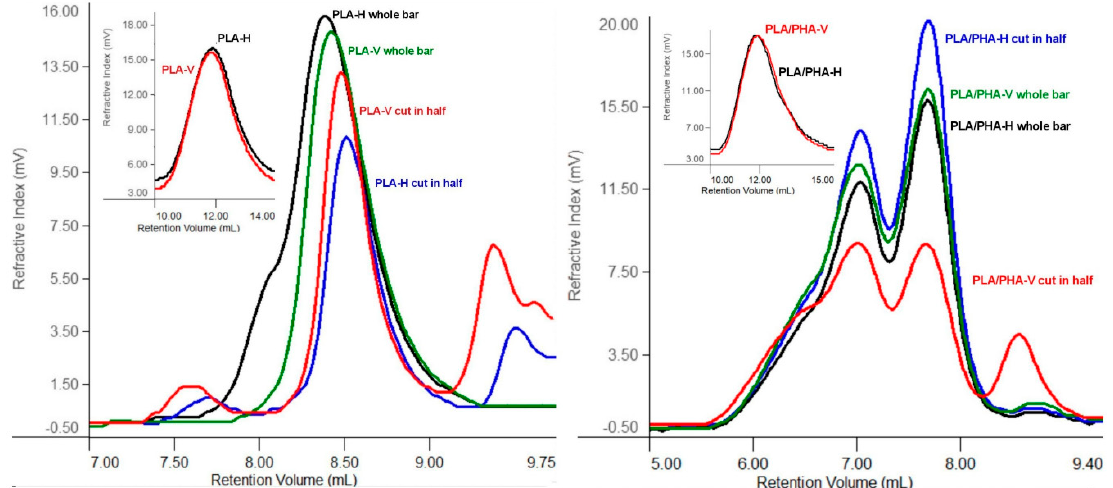
Figure 3. Overlay of selected gel permeation chromatography (GPC) chromatograms of PLA and PLA/PHA dumbbell-shaped specimens obtained by 3D printing in horizontal (H) and vertical (V) directions after 70 days of degradation at 70 °C (column with a linear range up to M w = 25,000 g/mol). A small picture shows the chromatogram of the material before degradation (two columns with a linear range of M w = 200–2,000,000 g/mol).